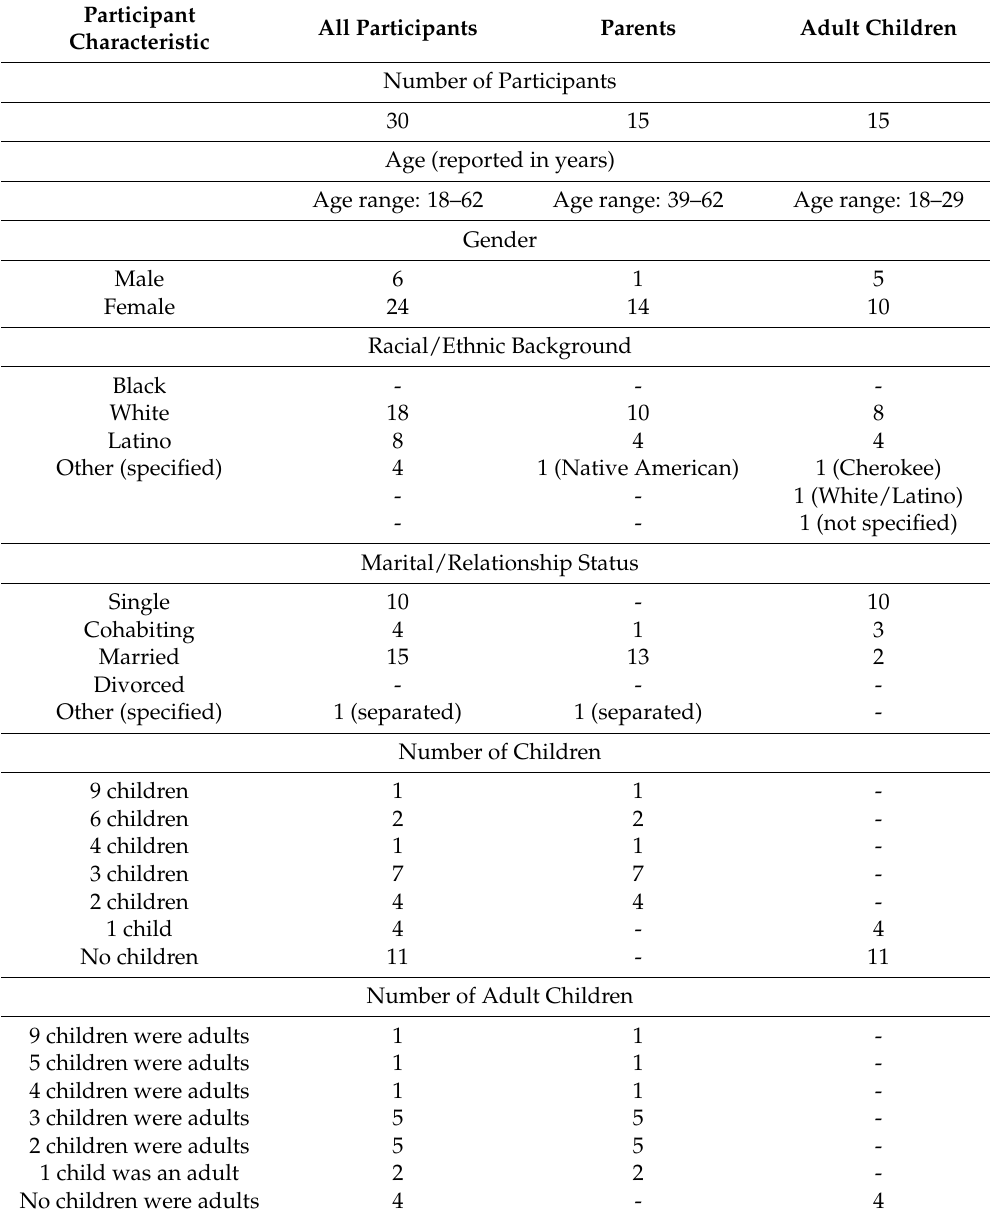
Table 1. Personal and Family Sample